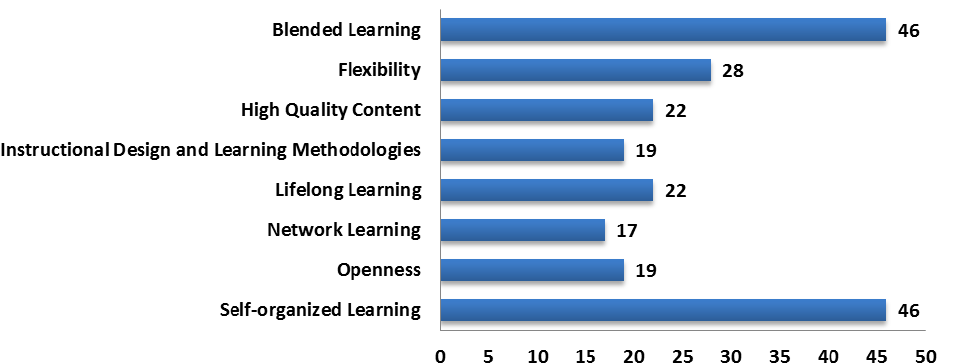
Figure 5. What is the purpose of your participation in this course? (N=